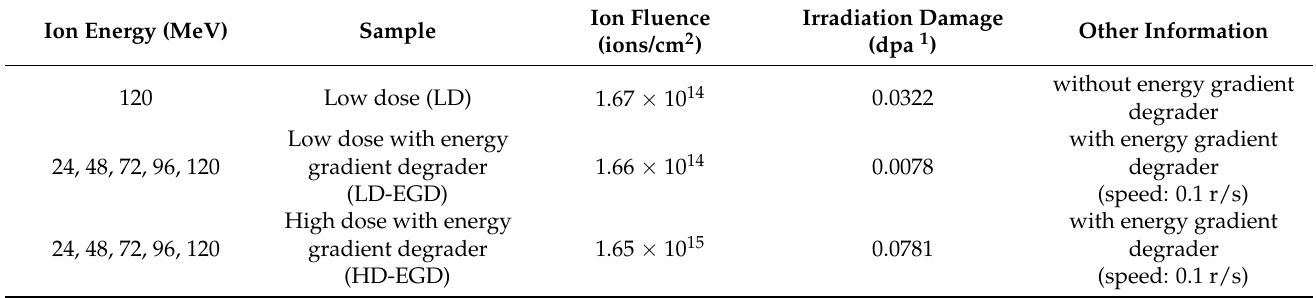
Figure 1. SRIM simulation of neon ion concentration distribution and damage distribution: ( a ) low dose (LD), ( b ) low dose with energy gradient degrader (LD-EGD), ( c ) high dose with energy gradient degrader (HD-EGD). Table 2. Detailed data of ion-irradiation experiments.